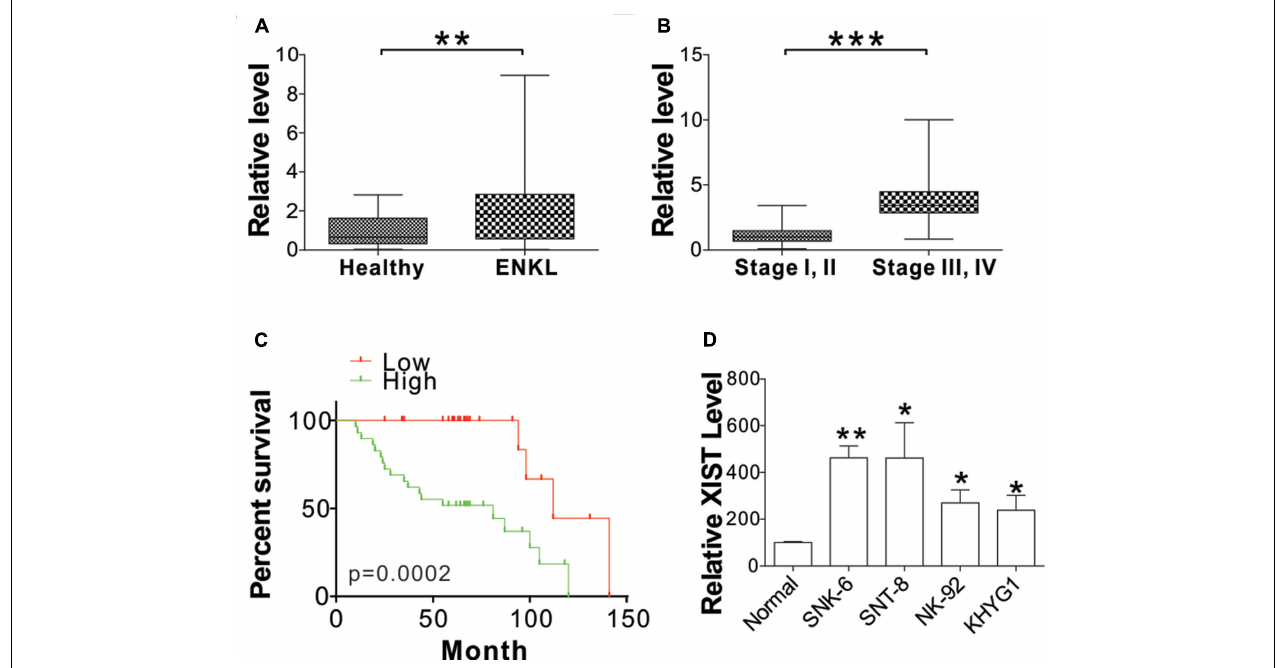
FIGURE 1 | XIST is upregulated in ENKL cells. (A) The mRNA level of XIST in the blood of ENKL patients (ENKL, n = 54) and healthy donors (Healthy, n = 24). (B) The mRNA level of XIST in the blood of ENKL patients at different stages (Stage I, II, n = 41; Stage III, IV, n = 13). (C) The survival of ENKL patients with high and low XIST expression. (D) The mRNA level of XIST in normal PBM and ENKL cells, n = 3 for each sample. * p < 0.05; ** p < 0.01; *** p <